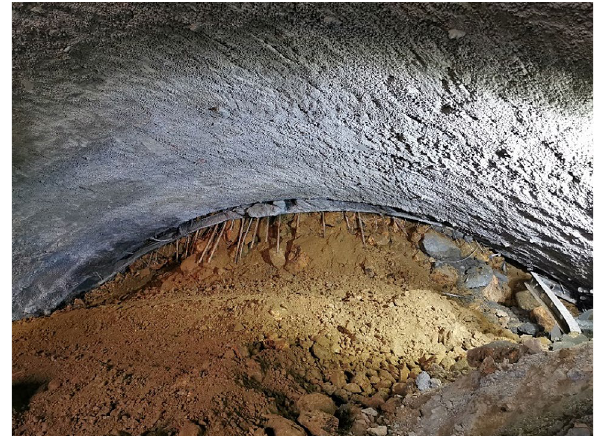
Figure 7. Tunnel collapse.